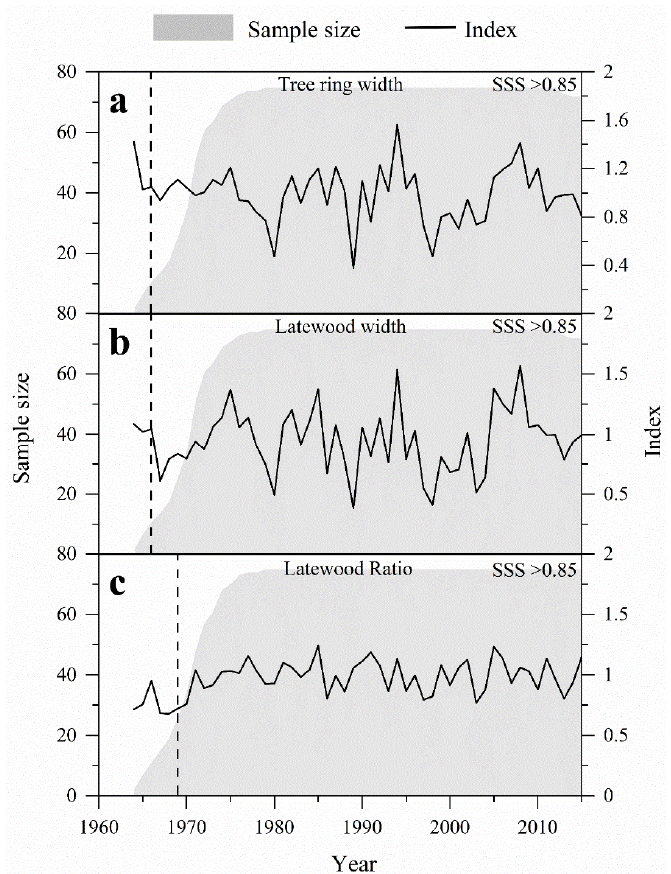
Figure 6. Tree-ring chronologies of P. massoniana based on ( a ) width and ( b ) latewood width and ( c ) latewood ratio. The reliable portions of the chronologies were determined by the statistic of subsample signal strength (SSS) over 0.85.